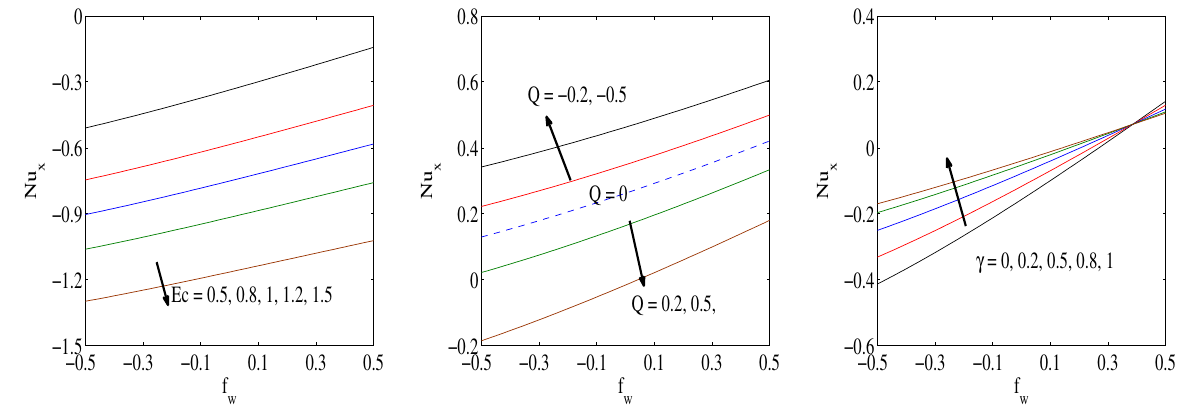
Figure 10. Nu x under the impact of Ec , Q and γ